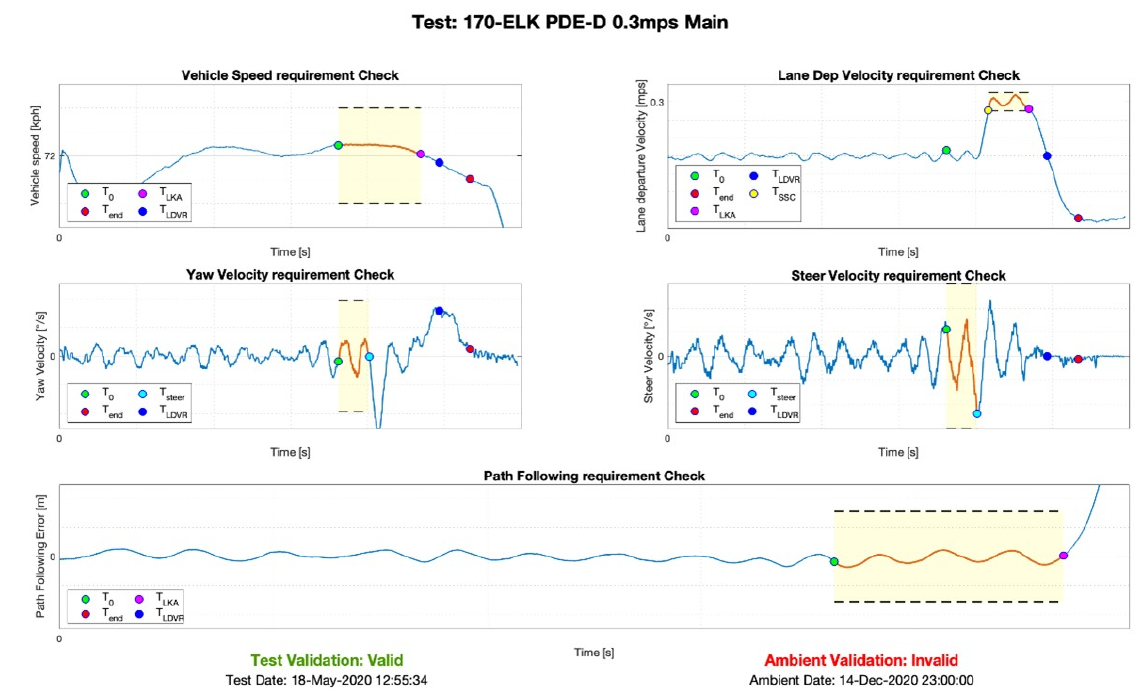
Figure 16. Post-processing results for a valid test LKA.